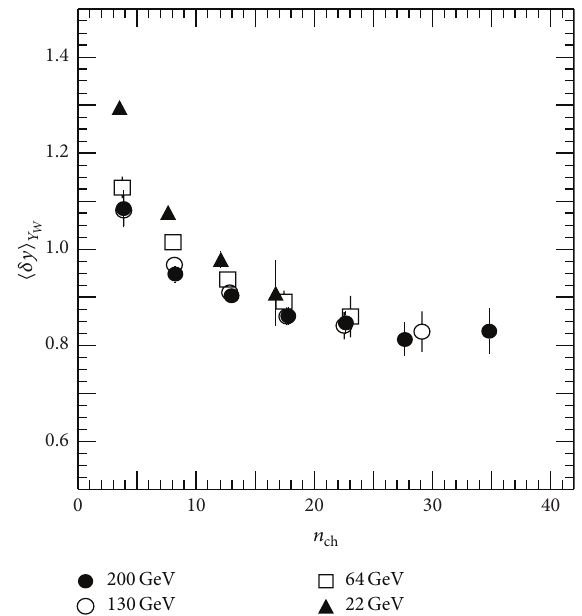
Figure 22: The width of balance functions in the rapidity region [−3, 3] for different multiplicities in pp collision at √𝑠 = 200 GeV for NN 130, 200 GeV. The graph is taken from